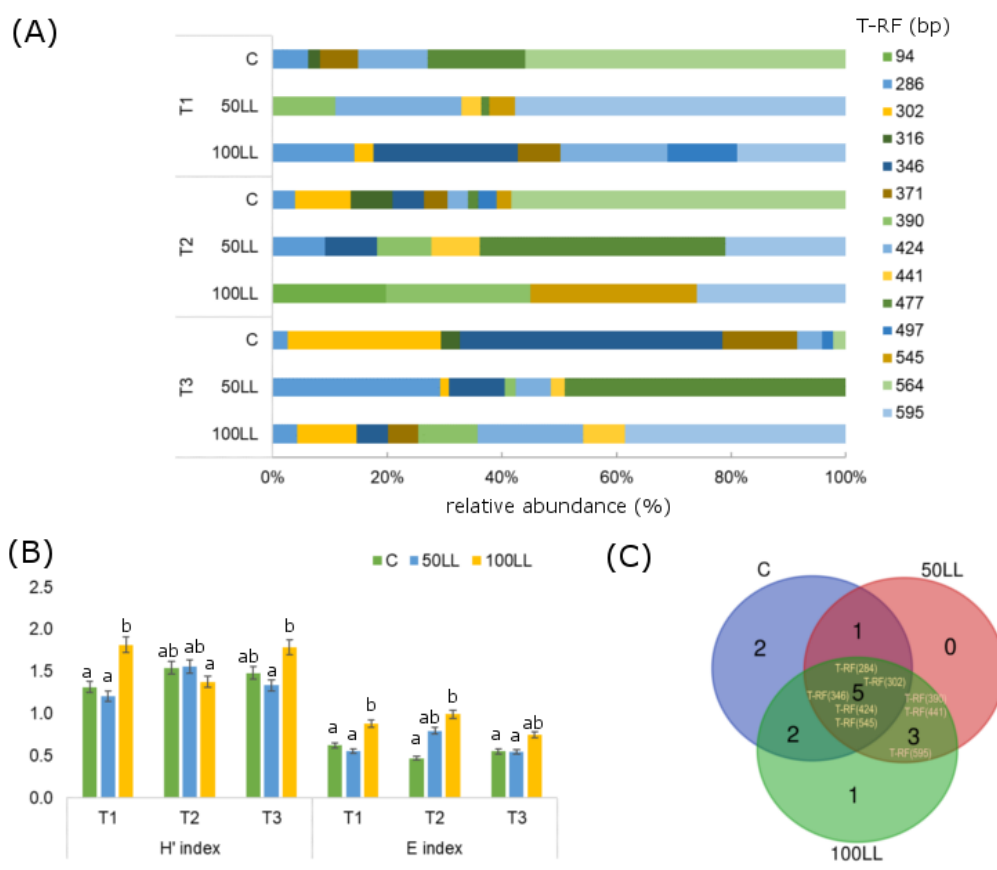
Figure 4. Relative abundance (%) of soil fungal terminal restriction fragments (T-RFs, bp) after Hae III digestion ( A ); Shannon—H’ and Evenness—E indices ( B ); relationships between fungal T-RFs presented as Venn diagram ( C ); The same letters presented on ( B ) describe non-significant differences between means assessed by Tukey HSD post-hoc test at p < 0.05.